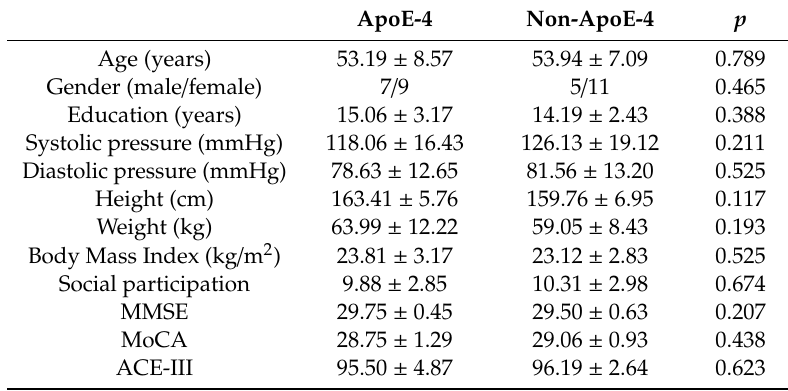
Table 1. Demographic characteristics (mean ± SD) of the ApoE-4 and non-APOE-4